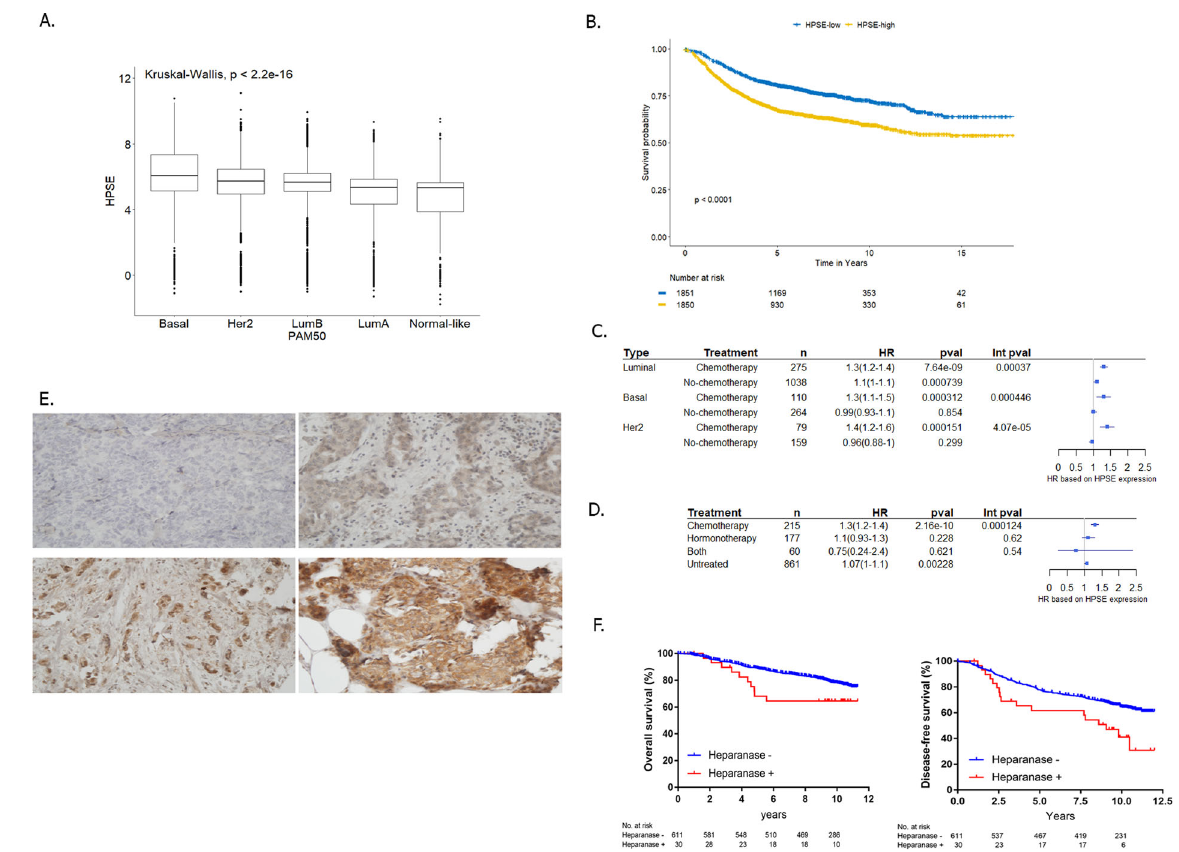
Fig. 1 Analysis of heparanase expression and outcome in patients with breast cancer. A Using the PAM50 classi fi cation model, patients were assigned to the main breast cancer molecular subtypes: Luminal A ( n = 3239), Luminal B ( n = 3375), basal ( n = 2074), HER2 + ( n = 1444), and normal-like ( n = 566). Basal and HER2-enriched cancers were more likely to possess high levels of heparanase in comparison to luminal cancers. B We assessed the prognostic value of quartiles of heparanase gene expression in all breast cancer patients ( n = 3701). Signi fi cance ( p -values) of differences in survival between patient groups as de fi ned by quartiles of heparanase expression is estimated by the log-rank test. C Forest plots according to heparanase gene expression in luminal ER-positive, basal, and HER2-enriched patients. The plots indicate Cox regression hazard ratios, 95% con fi dence intervals, and p -values for chemotherapy bene fi t for DDFS, as well as p -values of the interaction (int pval) between heparanase gene expression and chemotherapy treatment. D Forest plots according to heparanase gene expression in luminal ER-positive patients. The plots indicate Cox regression hazard ratios, 95% con fi dence intervals, and p -values for chemotherapy or hormonal bene fi t for DDFS, as well as p -values of the interaction (int pval) between heparanase gene expression and chemotherapy or hormone therapy treatment. E TMAs were stained for heparanase by IHC. The staining was analyzed according to the intensity (range: 0 – 3) right = 0, left = 3 strong staining. F Heparanase Kaplan – Meier survival curves in the BIG 2-98 cohort. OS = left and DFS =